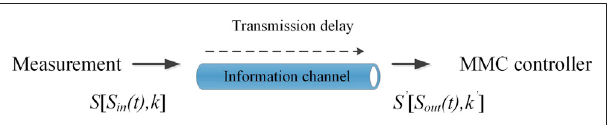
FIGURE 6 | Information transmission process through the